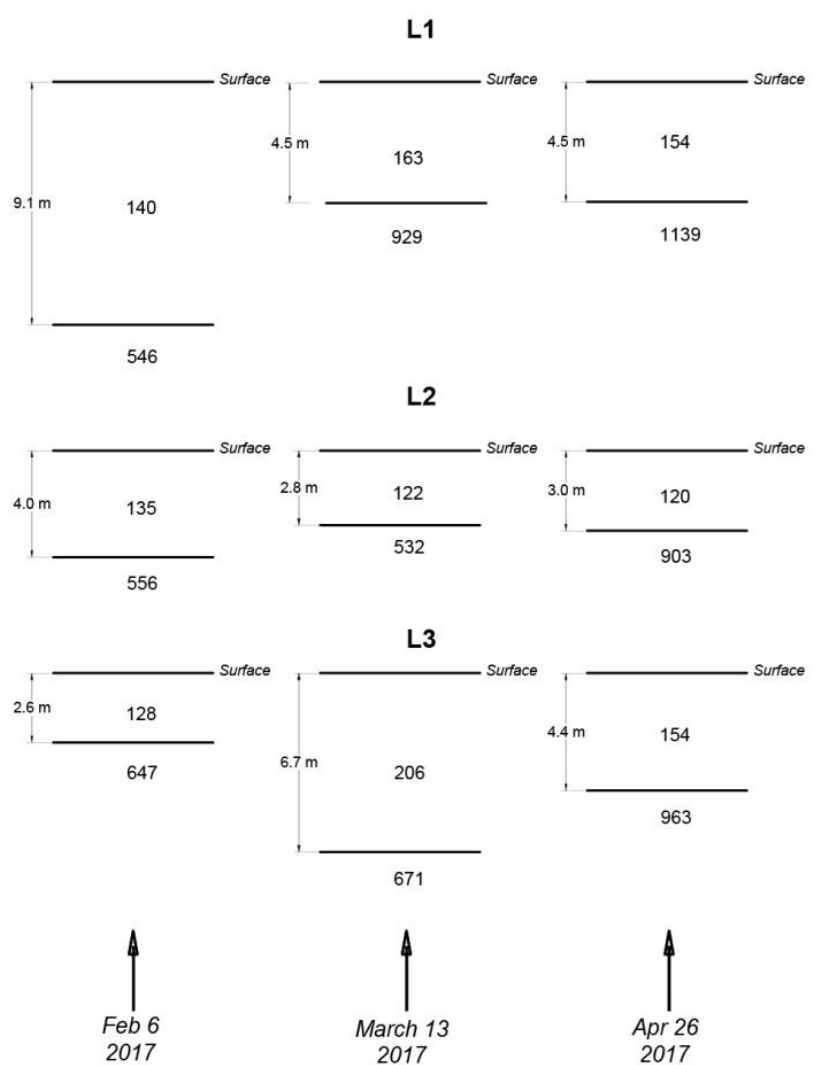
Figure 10. Summary of the two-layer shear seismic wave velocity (Vs) models derived from the MASW surveys conducted at locations L1 ( top ), L2 ( middle ) and L3 ( bottom ), on three different dates in 2017 (indicated at the bottom). See Figure 1 for experimental locations. The numbers correspond to seismic wave speed in m/s.